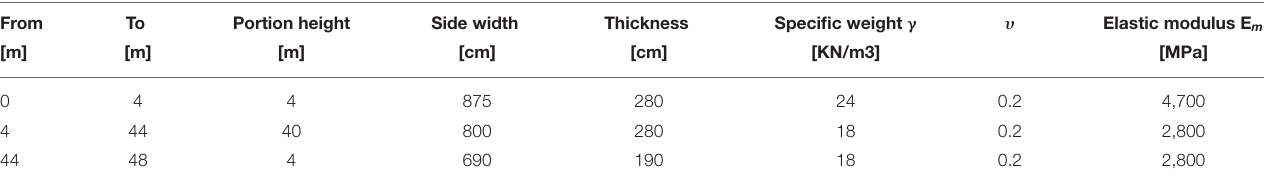
TABLE 2 | The main geometric characteristic and material properties of the different portions along the height of the Garisenda Tower. From To Portion height Side width Thickness Specific weight γ υ Elastic modulus E